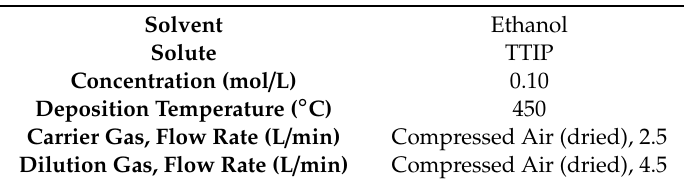
Table 3. Deposition condition of TiO 2